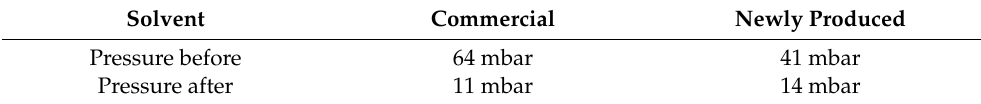
Table 2. Pressure measurements before and after the regeneration process, in compact machine. Solvent Commercial Newly Produced Pressure before 64 mbar 41 mbar Pressure after 11 mbar 14